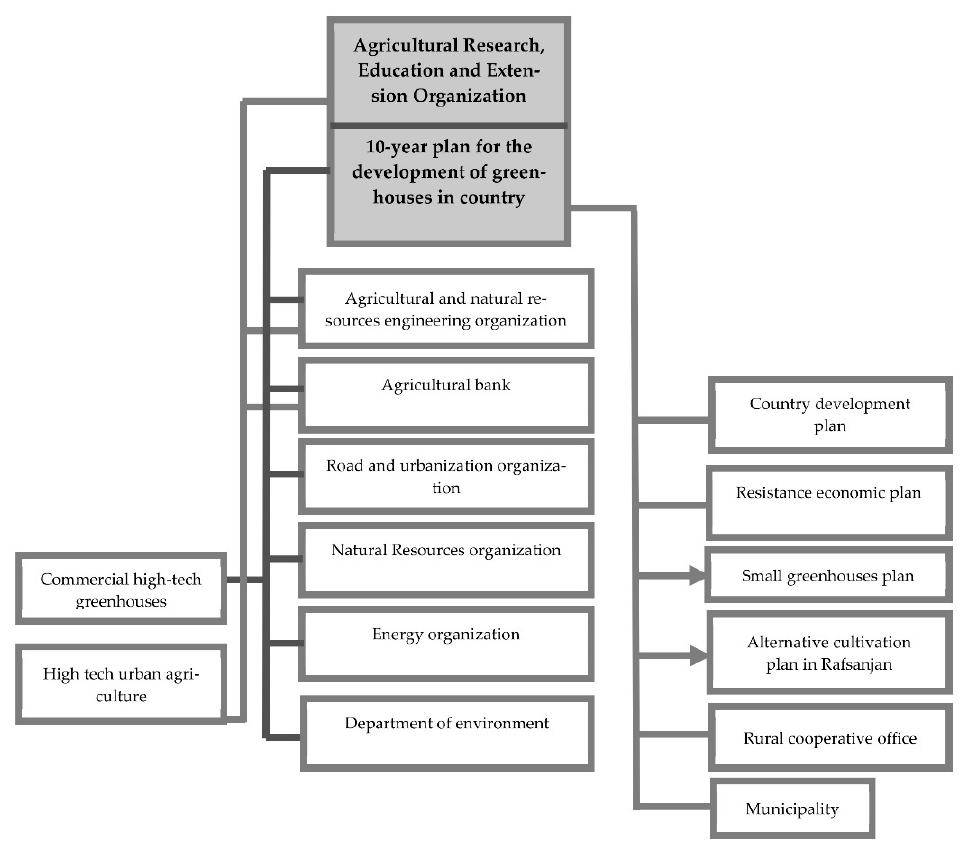
Figure 8. The first re-entanglement step.